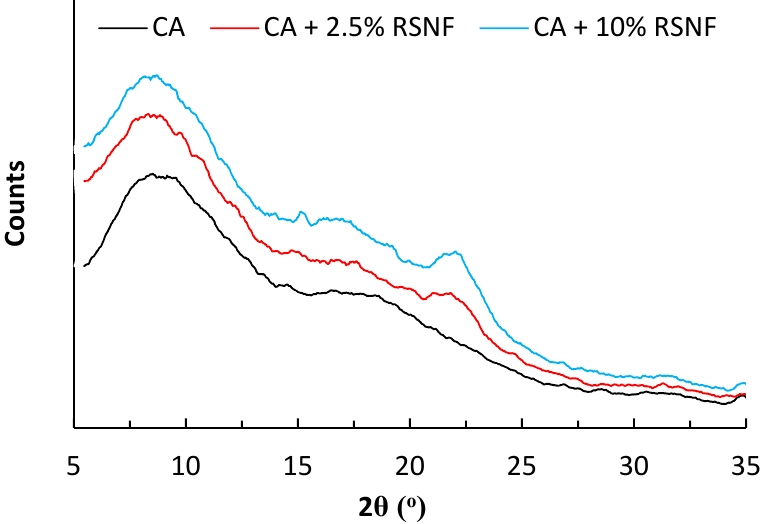
Figure 9. XRD patterns of CA films containing different ratios of RSNF.